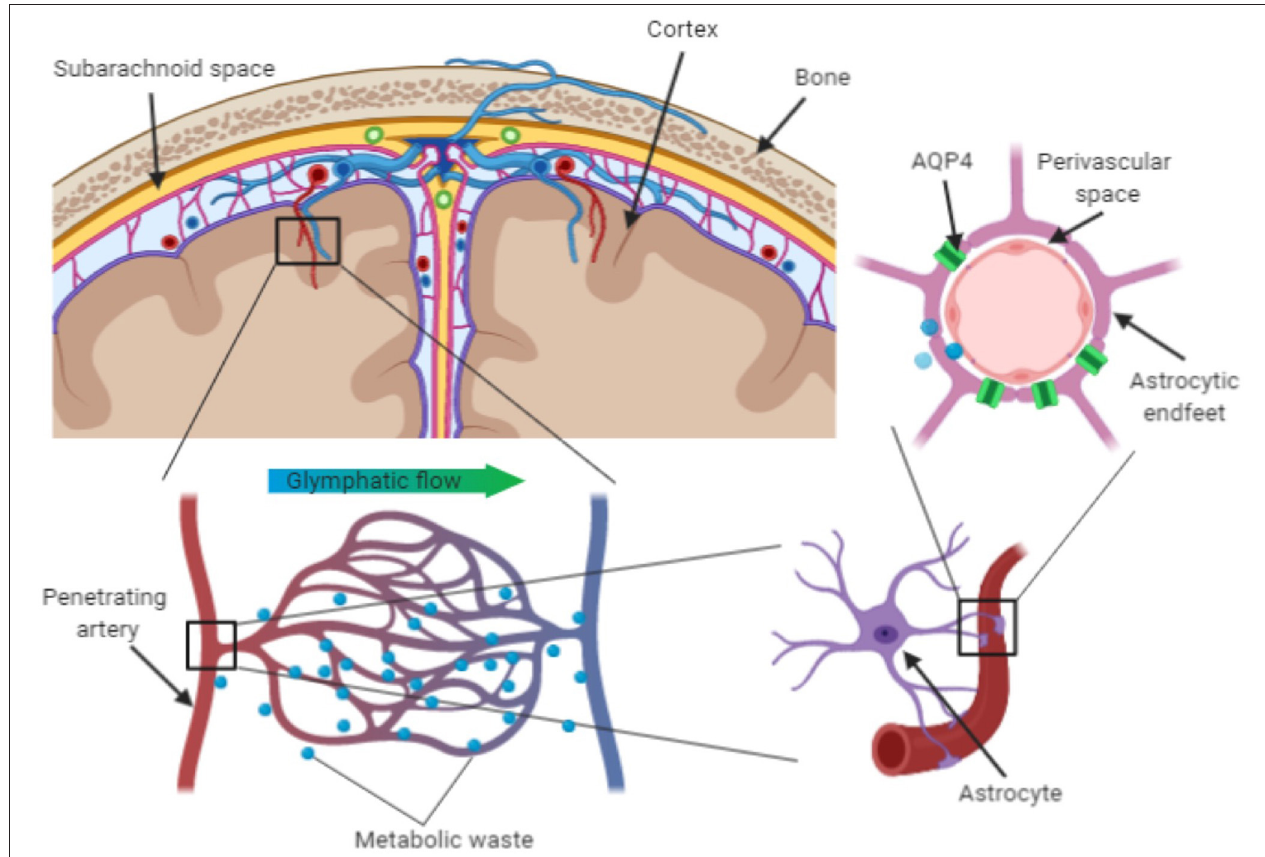
FIGURE 1 | Schematic representation of perivascular